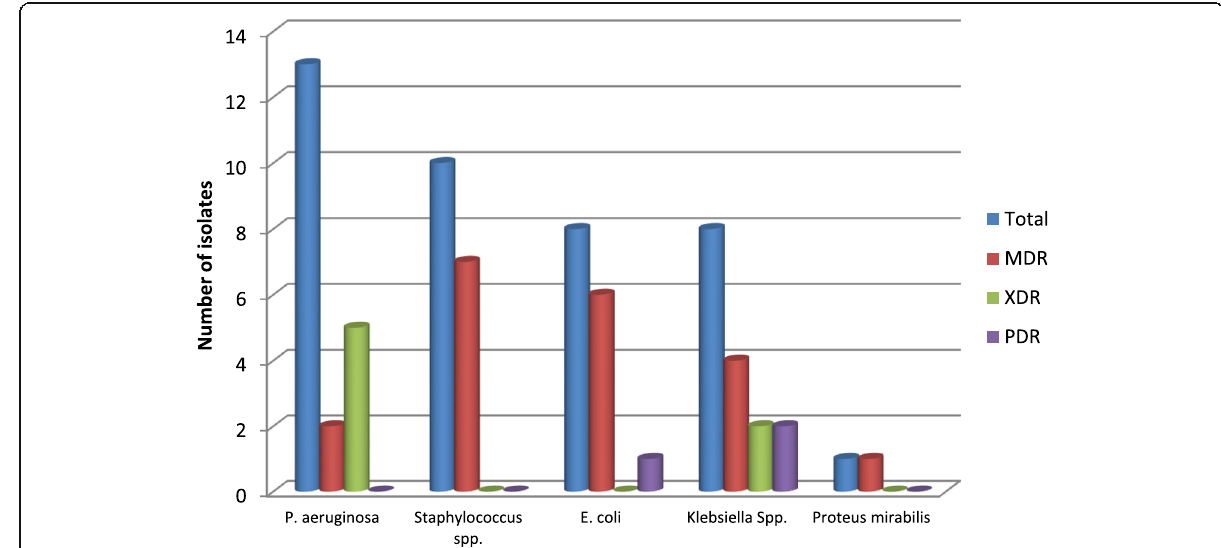
Fig. 3 Incidence of MDR, XDR, and PDR of the Gram-negative bacillus and Gram-positive coccus